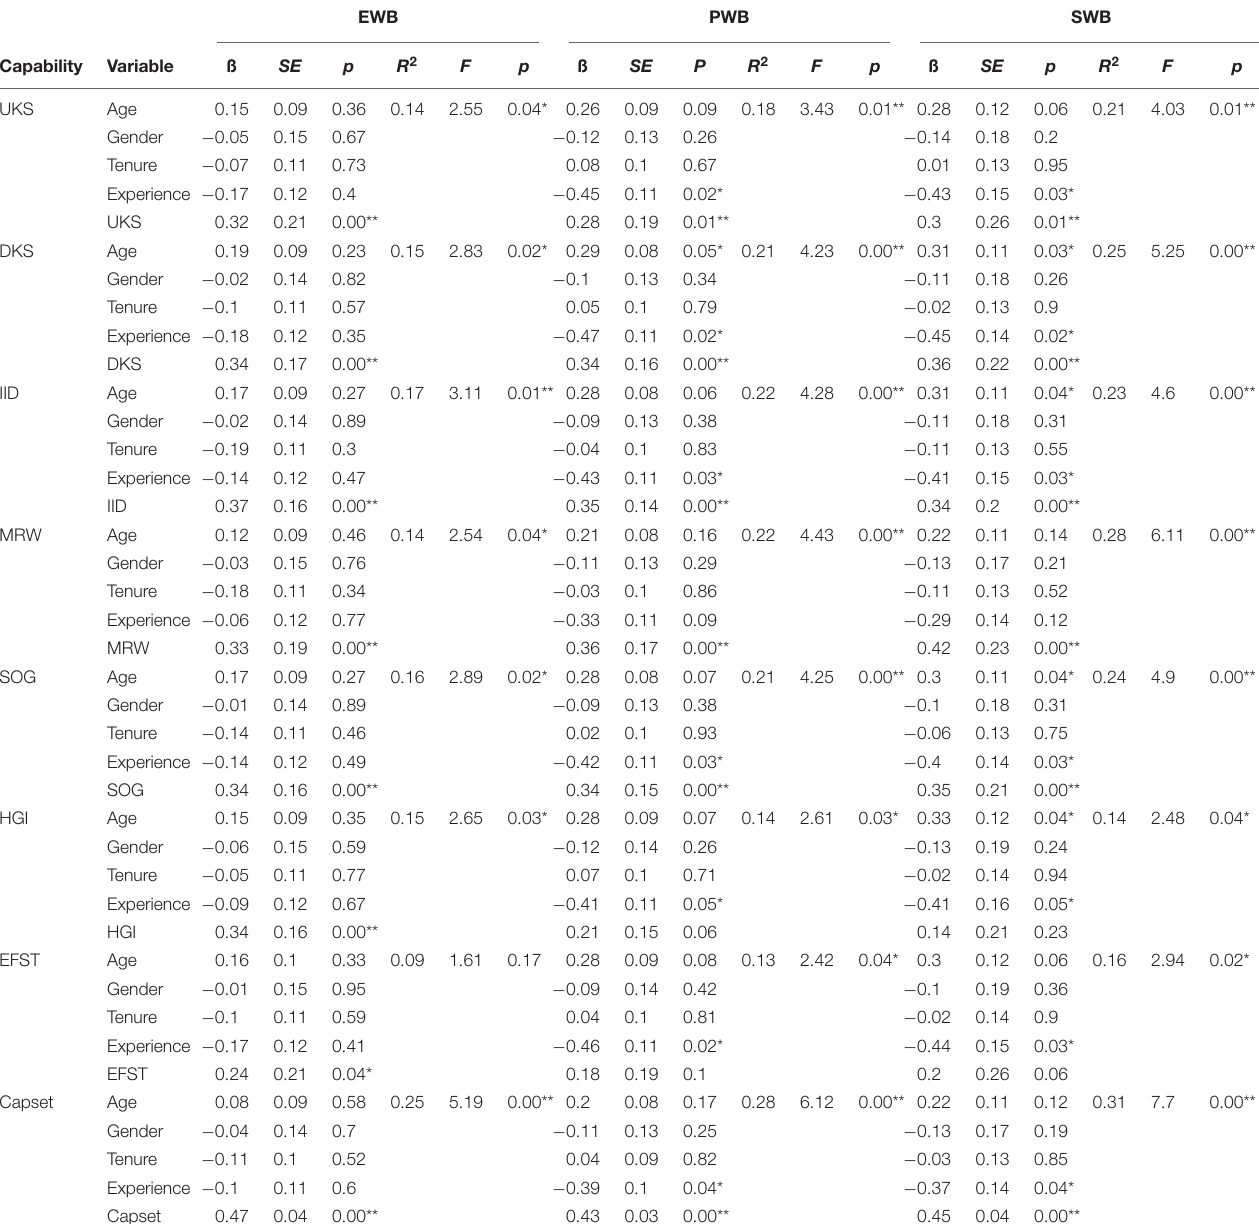
TABLE 4 | Multiple regression analyses of demographic variables, capabilities, and flourishing at